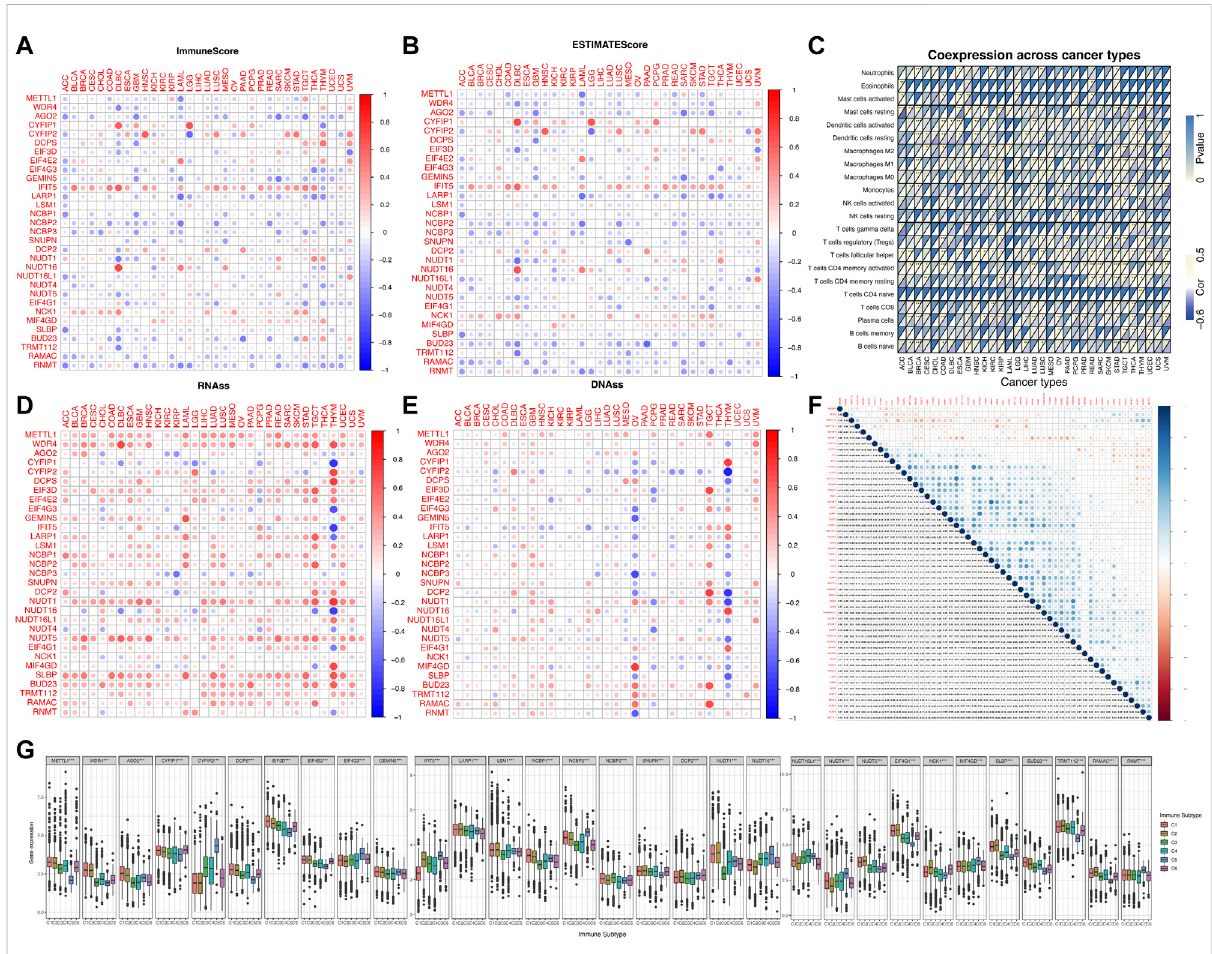
FIGURE 3 Correlation analysis between theexpression ofm7G-relatedregulators andthepan-cancerimmunemicroenvironmentwithfurtheranalysis of m6A. (A) Correlation between the expression of 31 m7G methylation regulators and the immune score. (B) Correlation between the expression of 31m7Gmethylationregulatorsandthestromalcell score. (C) Correlation between theenrichmentlevelofm7G regulators (m7Ggenesetscore) and tumor-associated immune cells in different cancers calculated by CIBERSORT. (D) Correlation between the expression of 31 m7G regulators andRNAss. (E) Correlationbetweentheexpressionof31m7GregulatorsandDNAss. (F) Theblueandreddotsindicatethattheexpressionofthem7G methylation regulators is positive and negative in relation to m6A methylation regulators, respectively. (G) The expression of m7G regulators within different immune in fi ltrate subtypes across all cancer types.